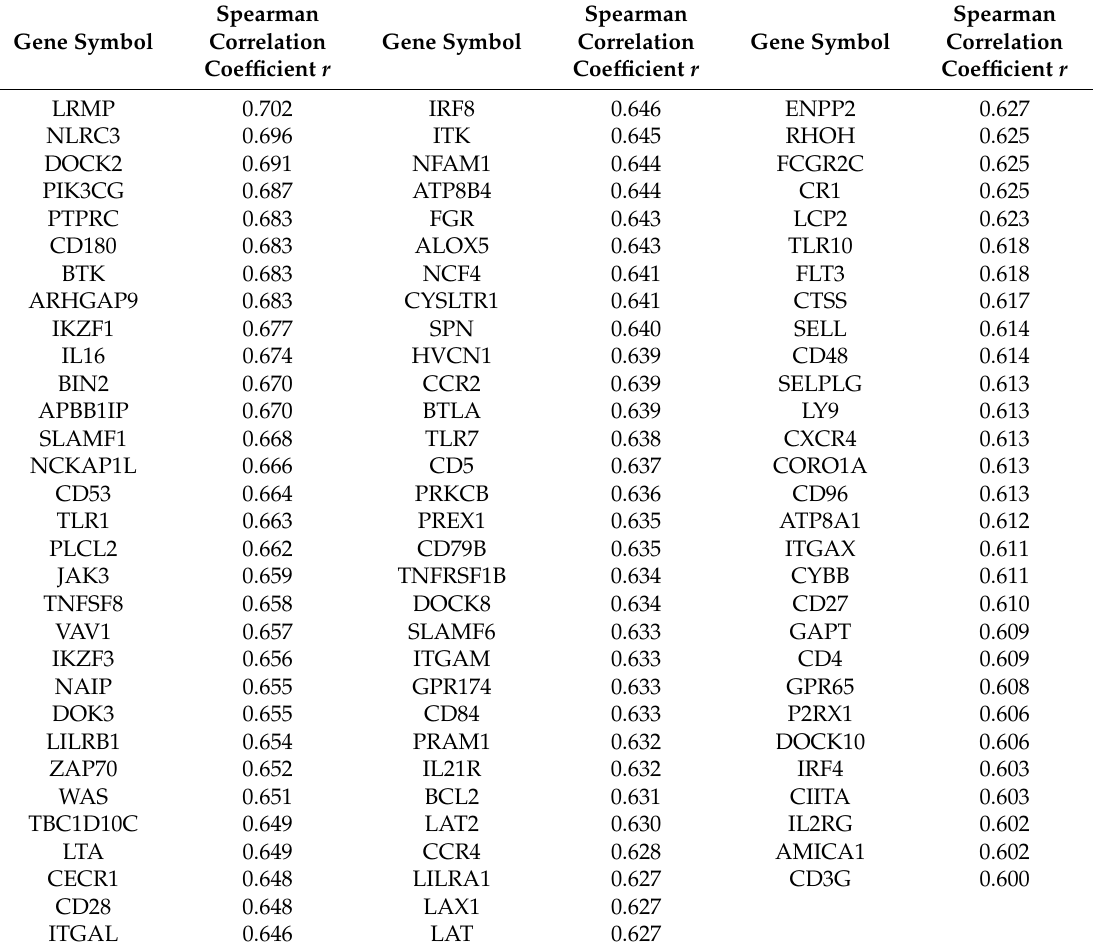
Table 3. List of immune genes associated with AP001056.1 expression ( r ≥ 0.600, p < 0.001). Spearman Gene Symbol Correlation Gene